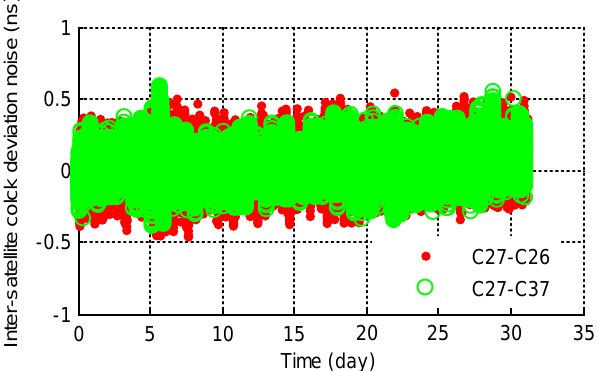
Figure 3. The precision of inter-satellite time comparison.